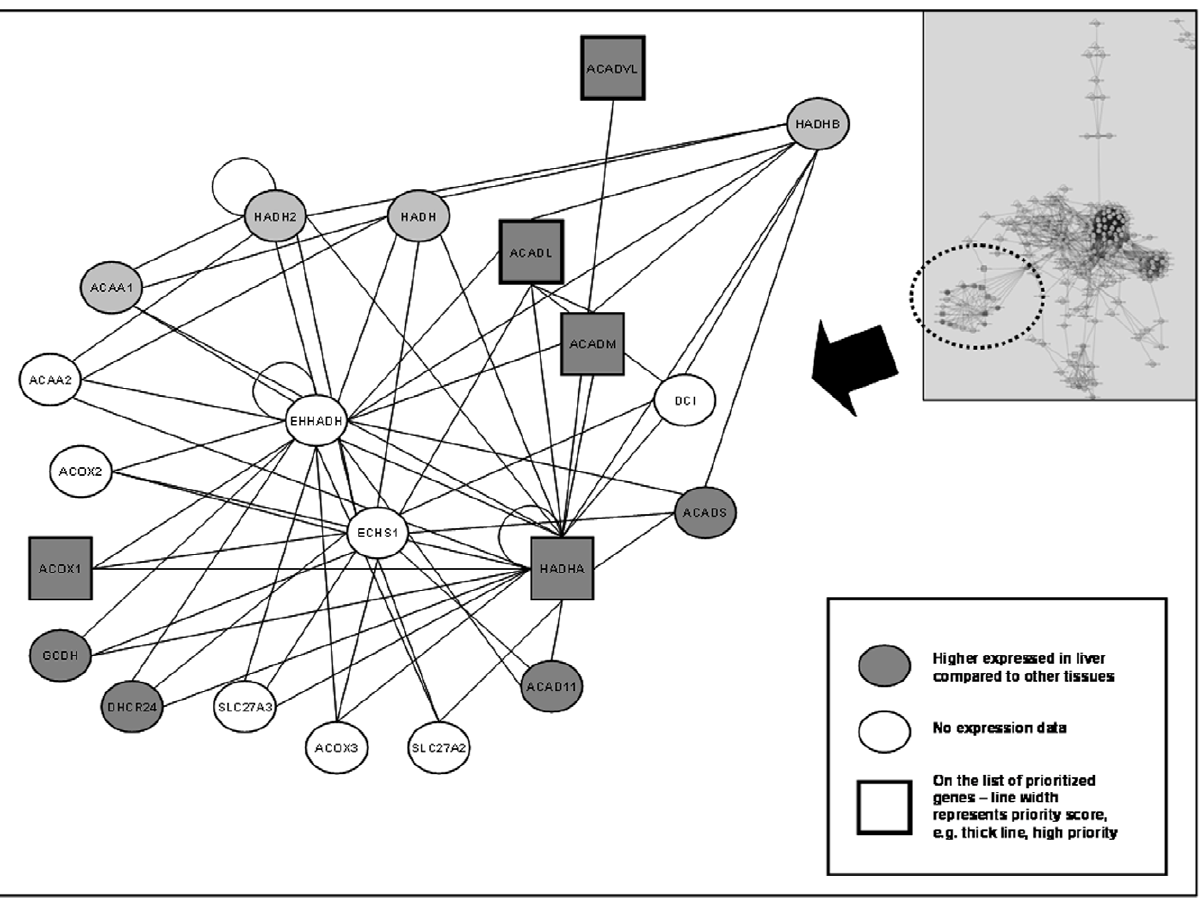
Figure 1. Interactome from the protein-protein interaction analysis. Enlarged picture of the interactome, from which EHHADH, ECHS1, HADHA, HADHB , and ACADL were selected for further analyses. Nodes are round if not on the list of prioritized candidate genes, and squared if on the list. The thickness of the line represents the priority score. The thicker the line, the higher prioritized on the list of candidate genes. Dark background color means highly expressed (above average) in liver compared to other tissues in the renormalized tissue expression data set [17]. White nodes represent proteins with no expression data available in the renormalized data set. However, in the orginal GNF tissue data set [16], all the genes corresponding to the white proteins have an expression level above the median for all tissues, supporting the observation that the proteins have a relative higher expression in liver. In the upper right corner is the entire protein-protein interaction network depicted. The smaller interactome is highlighted with a dashed circle. Cytoscape 2.6 (http://www.cytoscape.org/) was used to visualize the interactome.